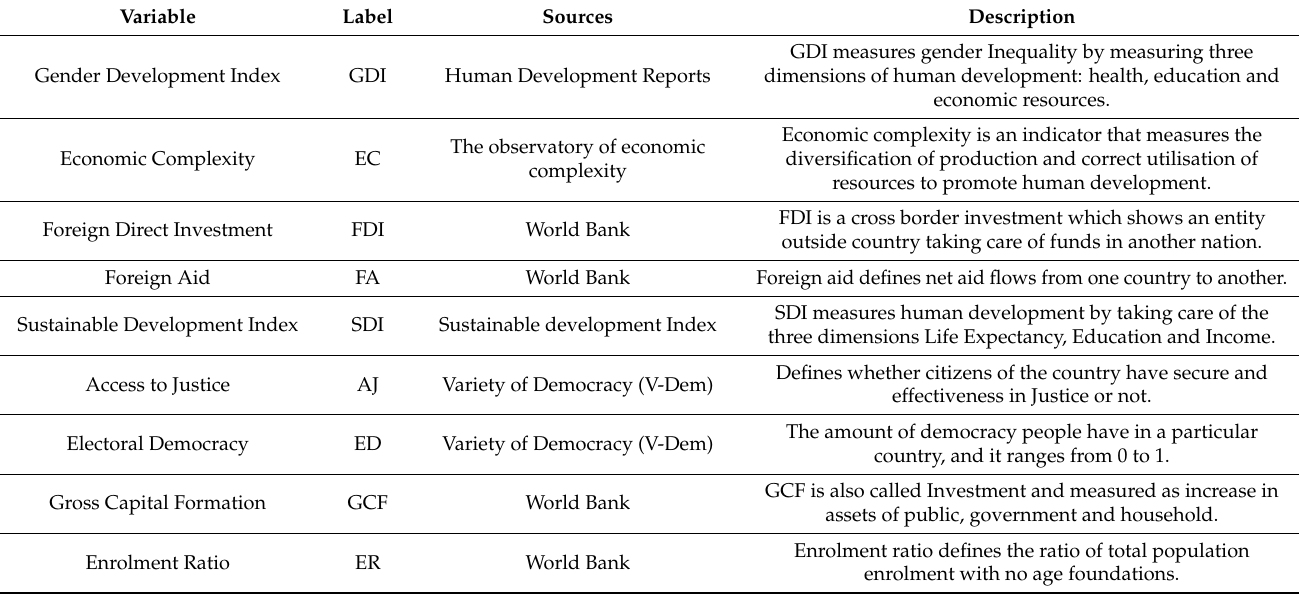
Table A1. Details of Data